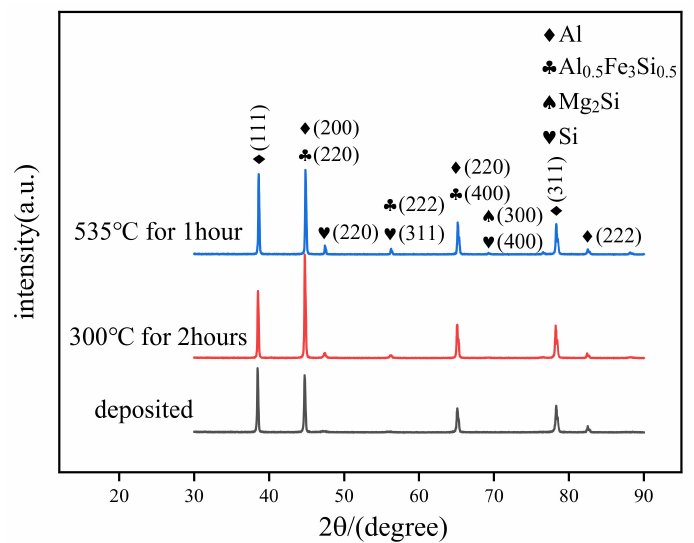
Figure 5. XRD curve and phase